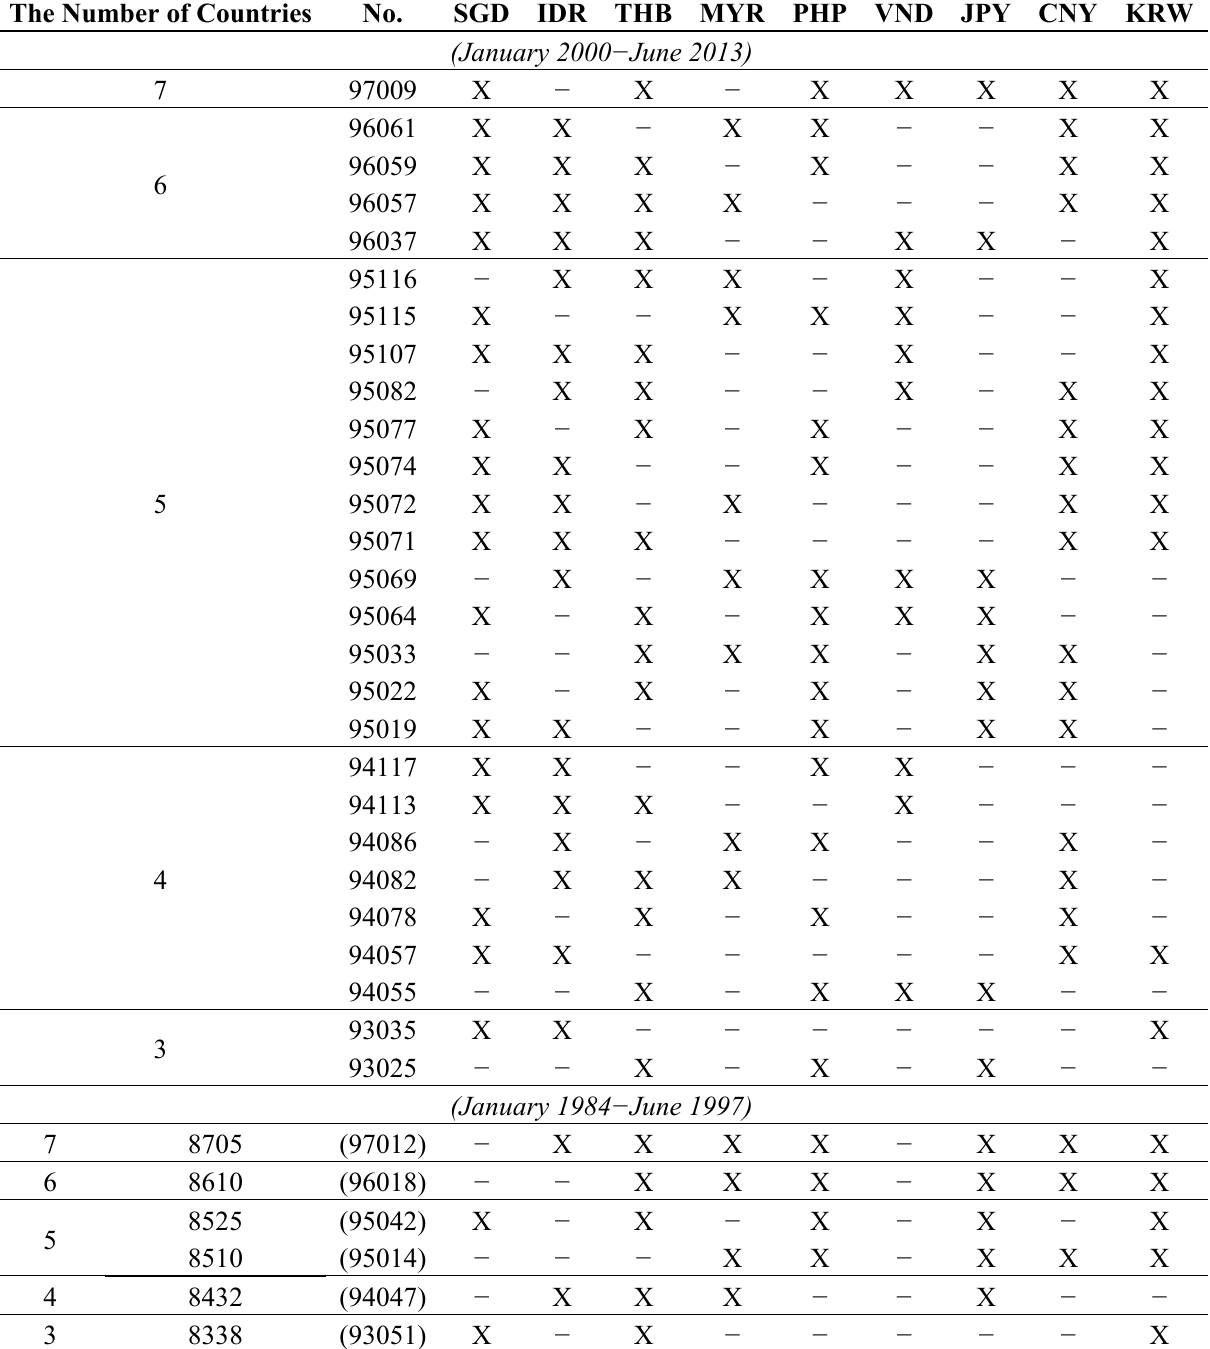
Table 5. Summary of Empirical Results (Candidates for member states of the Common Currency